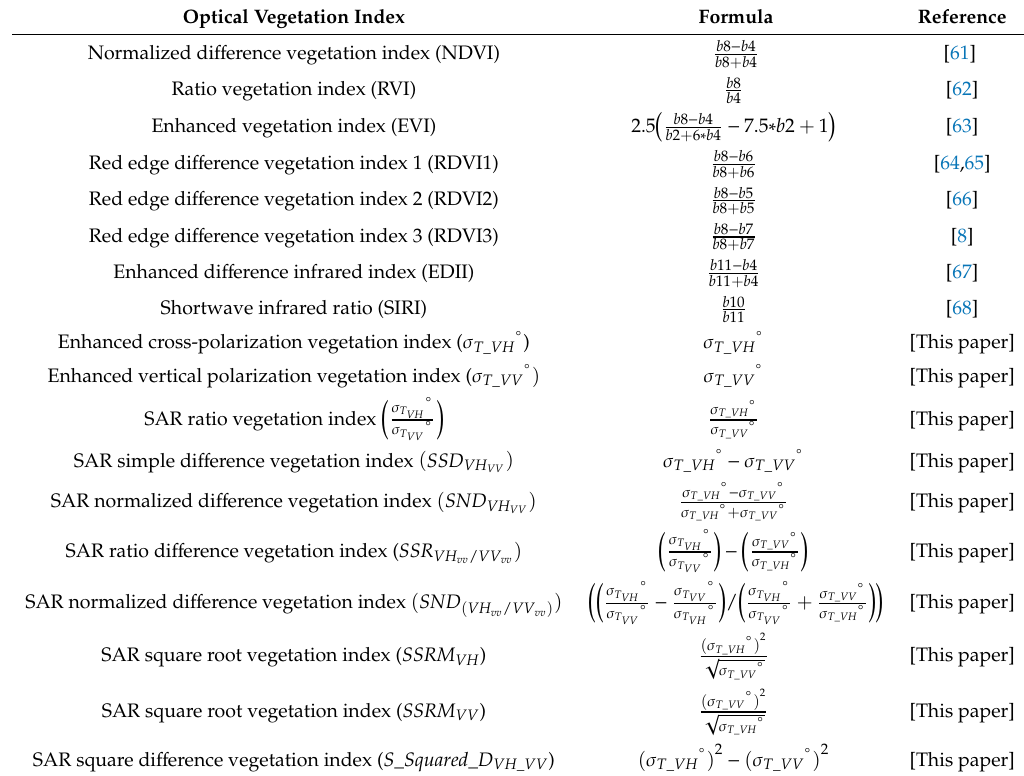
Table 2. Summary of selected optimal SAR and optical vegetation indices used in this study. Optical Vegetation Index Formula